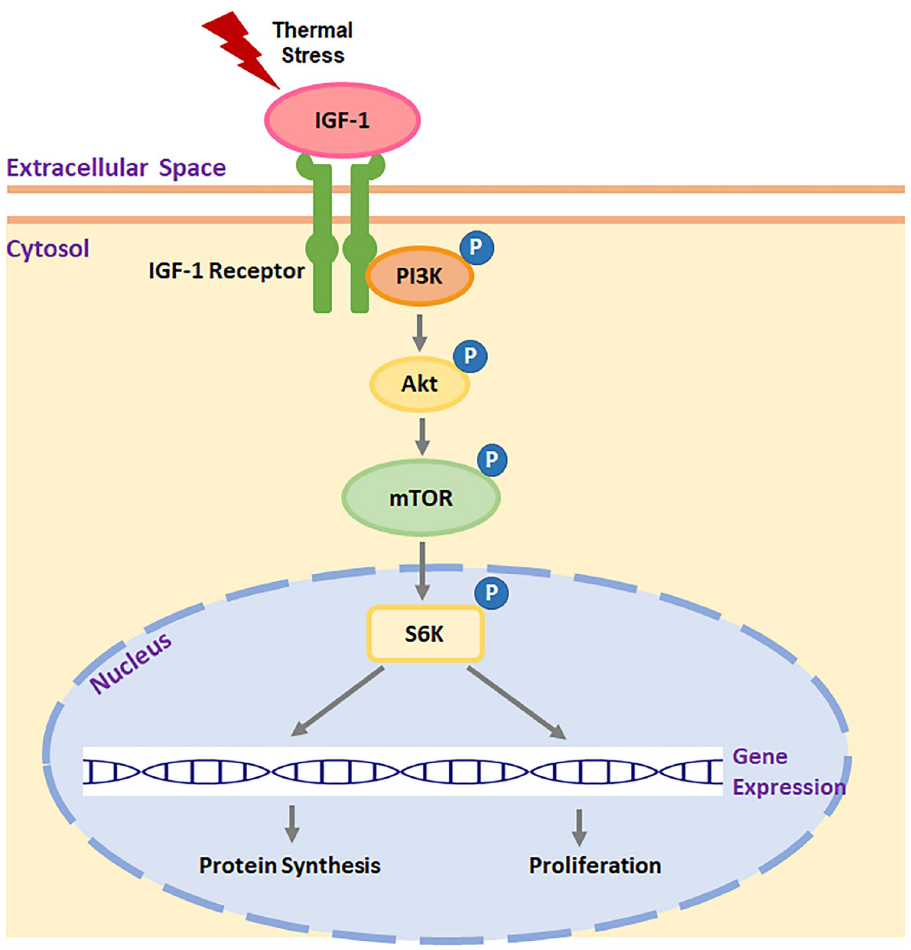
Fig 9. Schematic illustration of heat stress-induced IGF-1 regulating SC proliferation and protein synthesis through mTOR/S6K pathway. IGF-1: insulin-like growth facter-1, PI3K: phosphoinositide 3-kinase, Akt: protein kinase B, mTOR: mechanistic target of rapamycin, S6K: p70 S6 kinase.